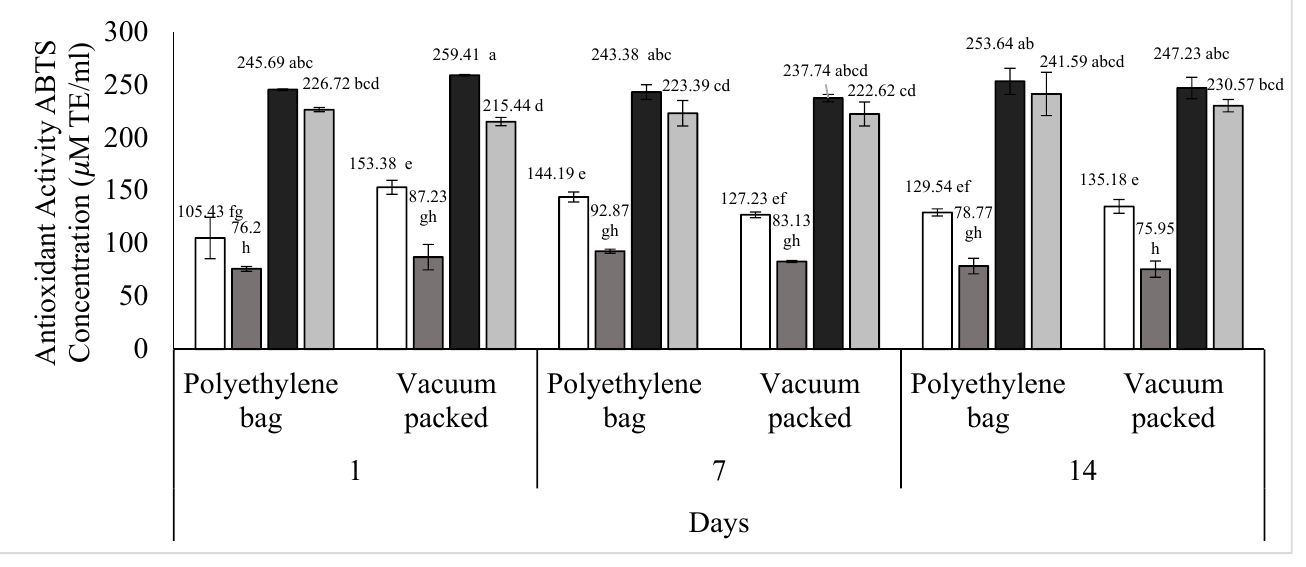
Figure 1. Antioxidant activity (ABTS ˙ method) of requeson cheese with different salt type and concentration treatments, conventional and vacuum packaging. a–h Values with a different superscript indicate significant statistical difference ( p < 0.05).